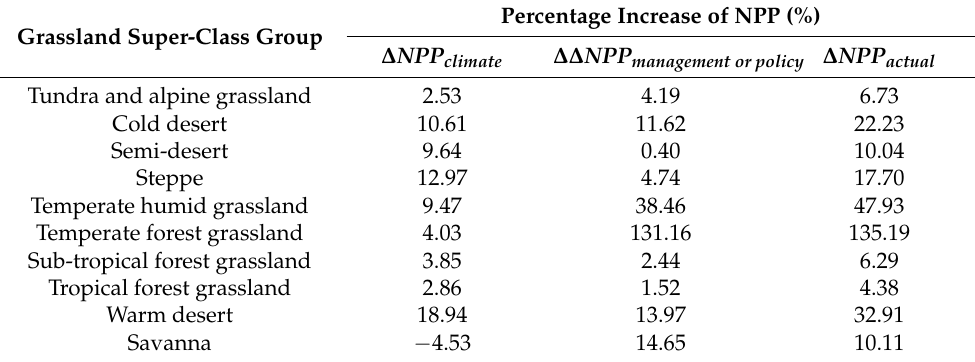
Table 4. The ∆ NPP actual , ∆ NPP climate , and ∆∆ NPP management or policy for each grassland super-class group after the implementation of the